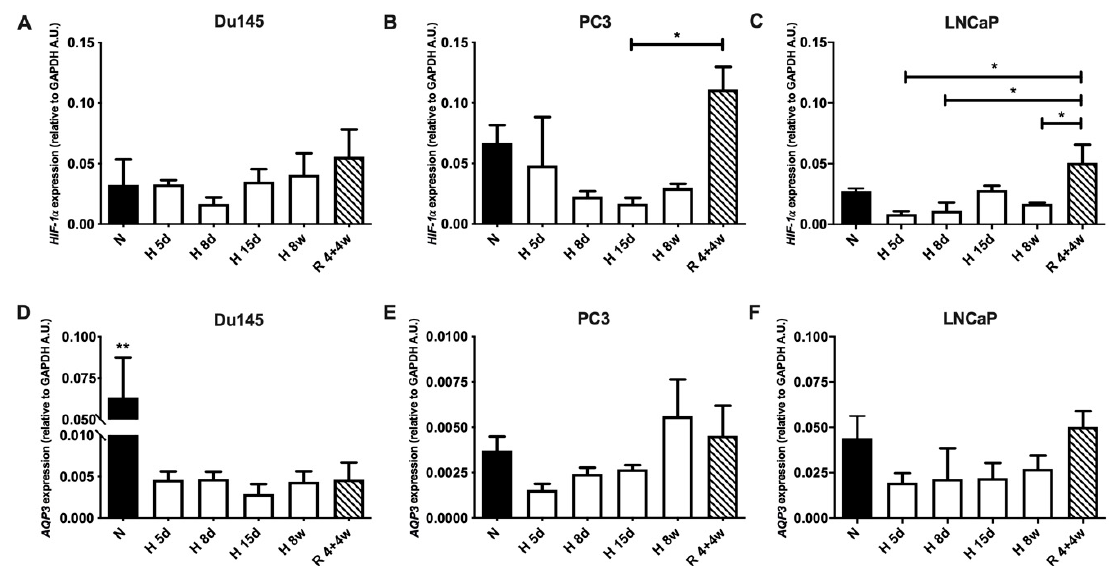
Figure 2. ( A – C ) Hypoxia-inducible factor (HIF)-1 α and ( D – F ) AQP3 mRNA levels in prostate cancer under normoxia (N—20% O 2 ), hypoxia (H—1% O 2 ) and recovery (R—hypoxia followed by normoxia). HIF-1 α mRNA expression for ( A ) Du145, ( B ) PC3 and ( C ) LNCaP. AQP3 mRNA expression for ( D ) Du145, ( E ) PC3 and ( F ) LNCaP. Data from cells under normoxia, acute hypoxia (5 d, 8 d, 15 d—days 5, 8 and 15), chronic hypoxia (8 w—8 weeks) and recovery (4 + 4 w—4 weeks hypoxia + 4 weeks normoxia). Levels of mRNA for both AQP3 and HIF-1 α are relative to GAPDH levels for the same sample. Data represent mean ± SEM of a minimum of three independent experiments. ** p < 0.01 * p < 0.05.